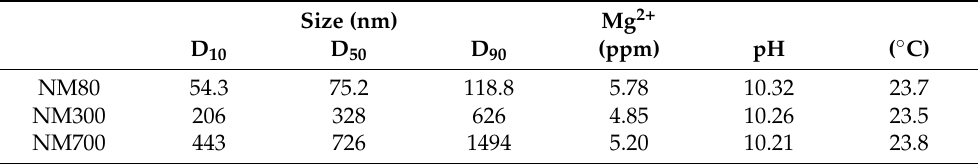
Figure 1. Characterization of NM80, NM300, and NM700 using SEM, DLS, and XRD. ( A ) SEM images of NM80, NM300, and NM700 from the top. Scale bars indicate 1 µm (×20,000). ( B ) Nanoparticle size measurement using DLS or laser diffraction particle size analyzer. ( C ) XRD patterns and important directions of magnesium hydroxide nanoparticles are indicated ((001), (101), and (110) from the left). Table 2. Characterization data of NM80, NM300, and NM700 obtained using DLS, the laser diffraction particle size analyzer, ICP, and the pH meter. The analyses were performed at a concentration of 500